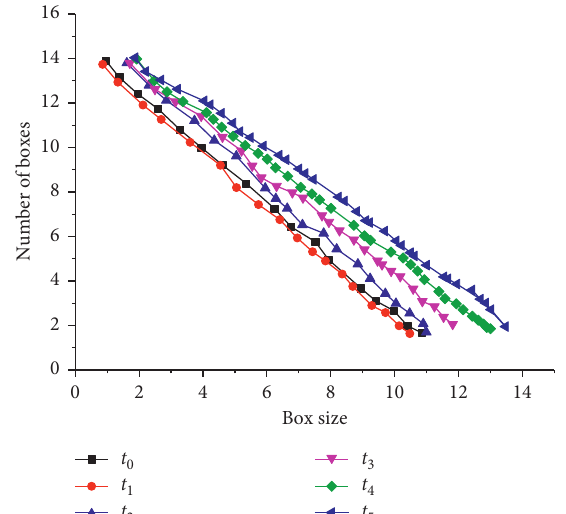
Figure 11: The fractal dimension analysis results of the weighted brain function network corresponding to different time stages.